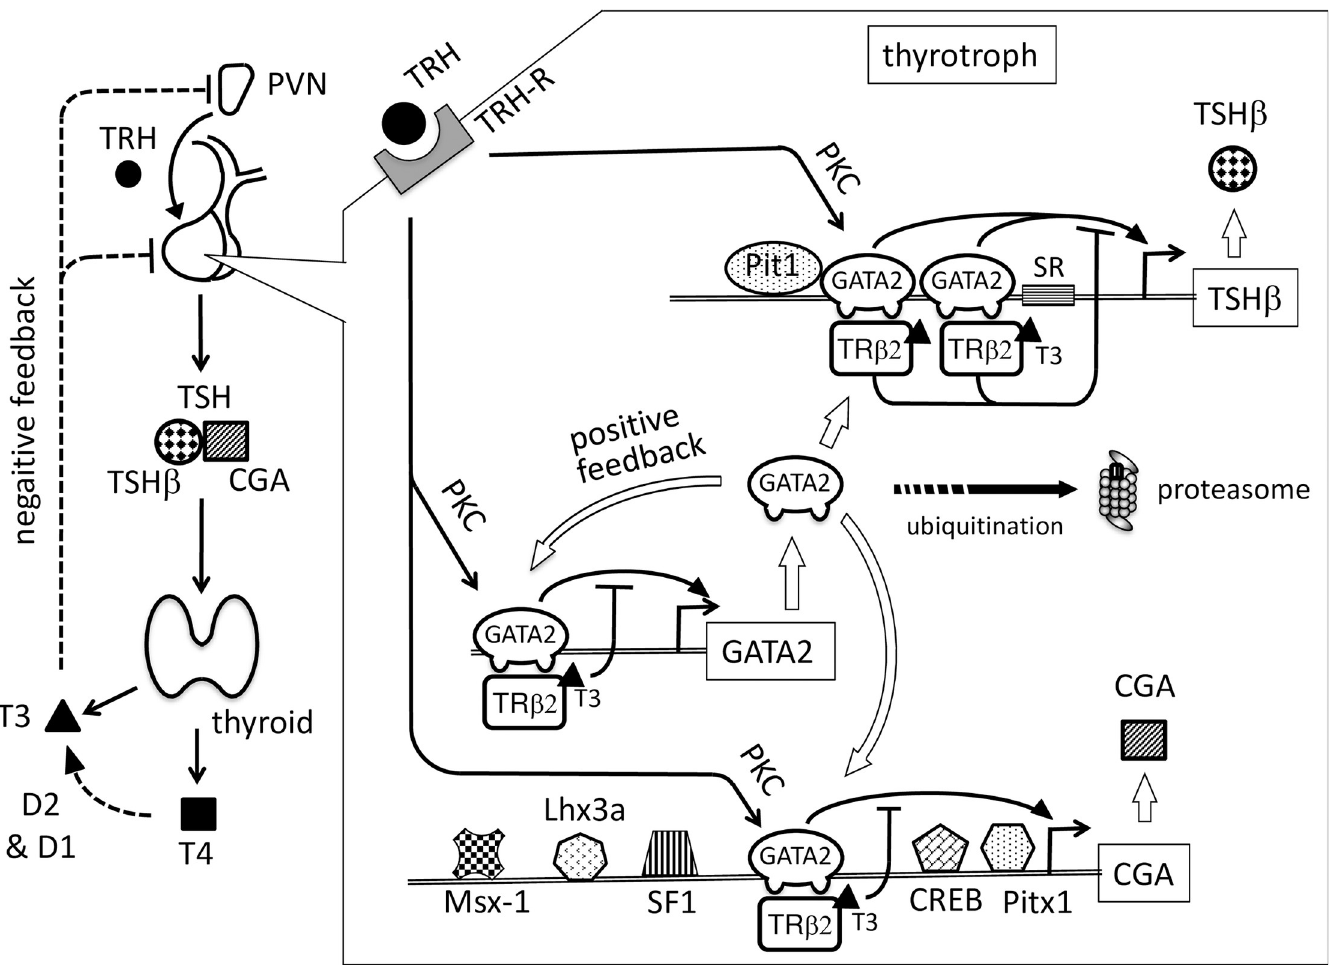
Fig 7. A schematic representation of hypothalamus-pituitary-thyroid (H-P-T) axis and transcriptional regulation of the GATA2, TSH β and CGA genes by GATA2 and liganded TR β 2 in thyrotroph. To simplify, only one GATA-RE is illustrated in the 5’ region of the GATA2 gene. In a TRH-dependent manner, TRH-R stimulates the transcriptional activity of GATA2 via the PKC pathway. In contrast, TR β 2 associates with the Zn-finger region of GATA2 via protein-protein interaction, resulting in the T3-dependent interference of GATA2-dependent transactivation (tethering mechanism). Our study suggests that liganded TR β 2 inhibits not only the transcription of the TSH β and CGA genes but also the positive feedback autoregulation of the GATA2 gene. Thus, there are the intracellular cascades of T3-dependent negative regulation between GATA2 and TSH β /CGA. Reduction of GATA2 protein expression by T3 appears to occur at transcriptional level and is independent from the ubiquitin-proteasome system. T3 also causes TSH β mRNA to be unstable. D2, type 2 deiodinase (the major deiodinase in thyrotroph). SR, suppressor region (see main text). In addition to GATA2, the CGA promoter is regulated by multiple transcription factors including Msx1, SF-1, Lhx3a, cAMP response element binding protein (CREB) and Ptx1